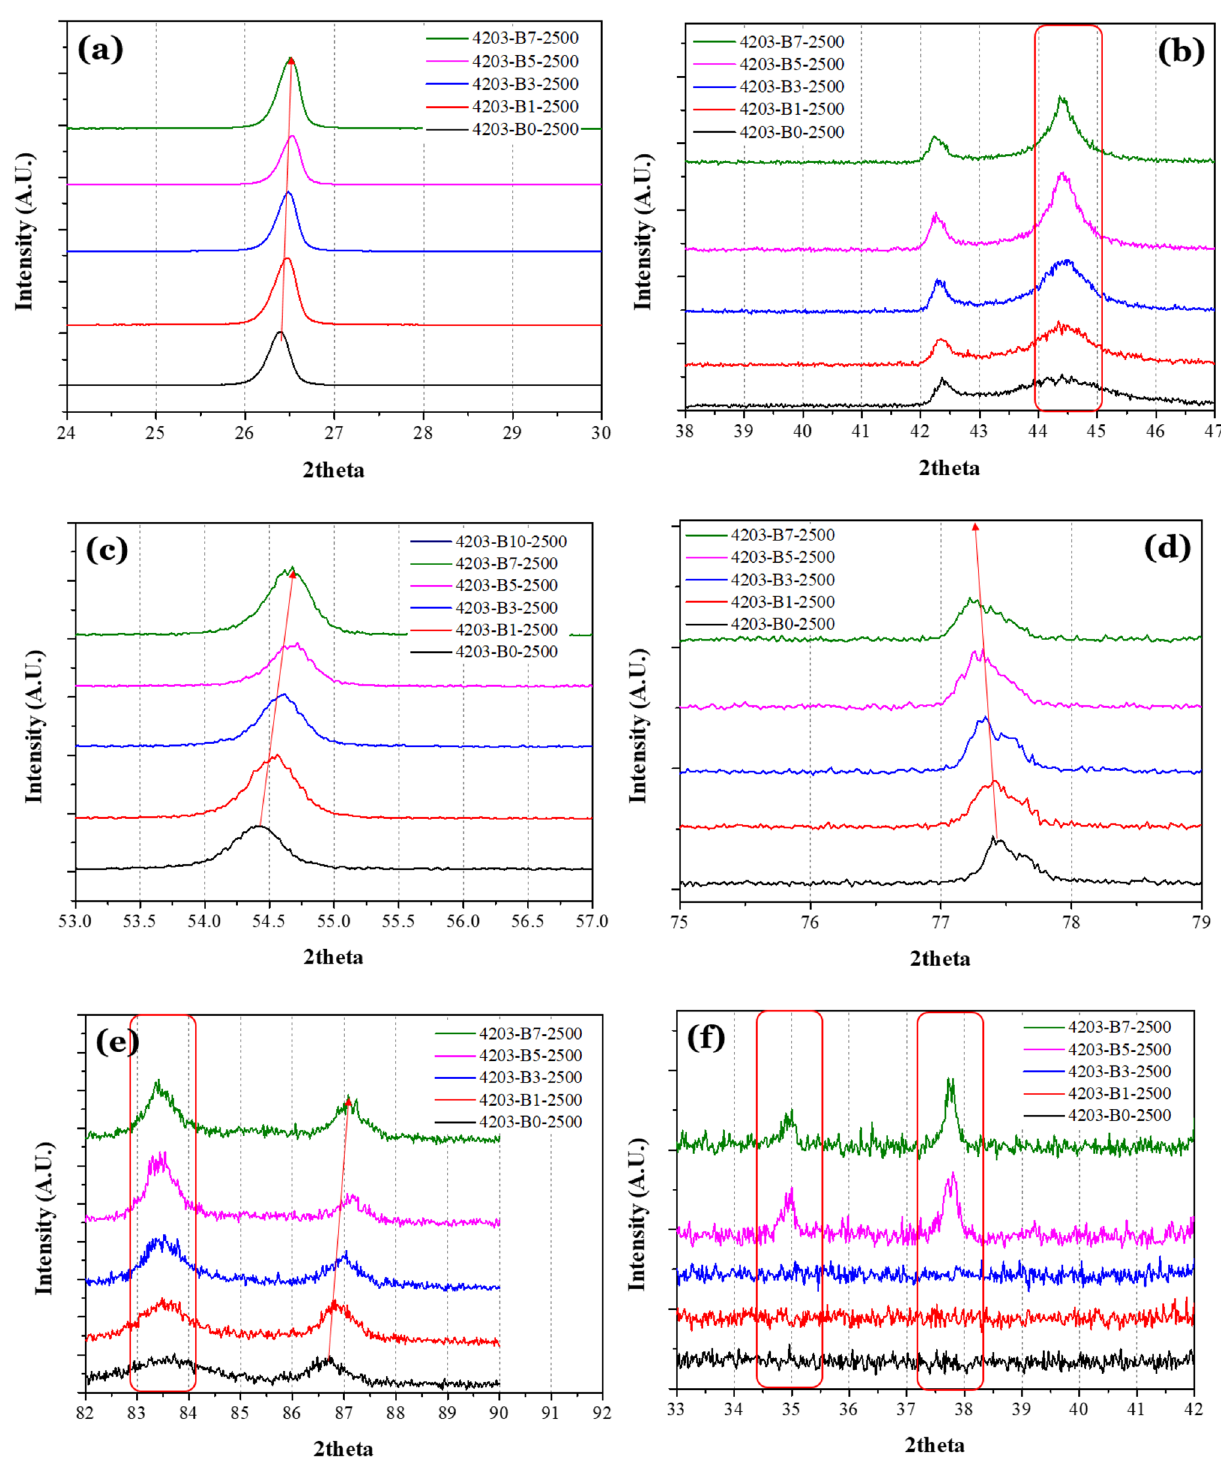
Fig. 3 X-ray diffraction patterns of 4203-BX-2500: a d(002), b d(100), d(101), c d(004), d d(110), e d(112), d(006), f B